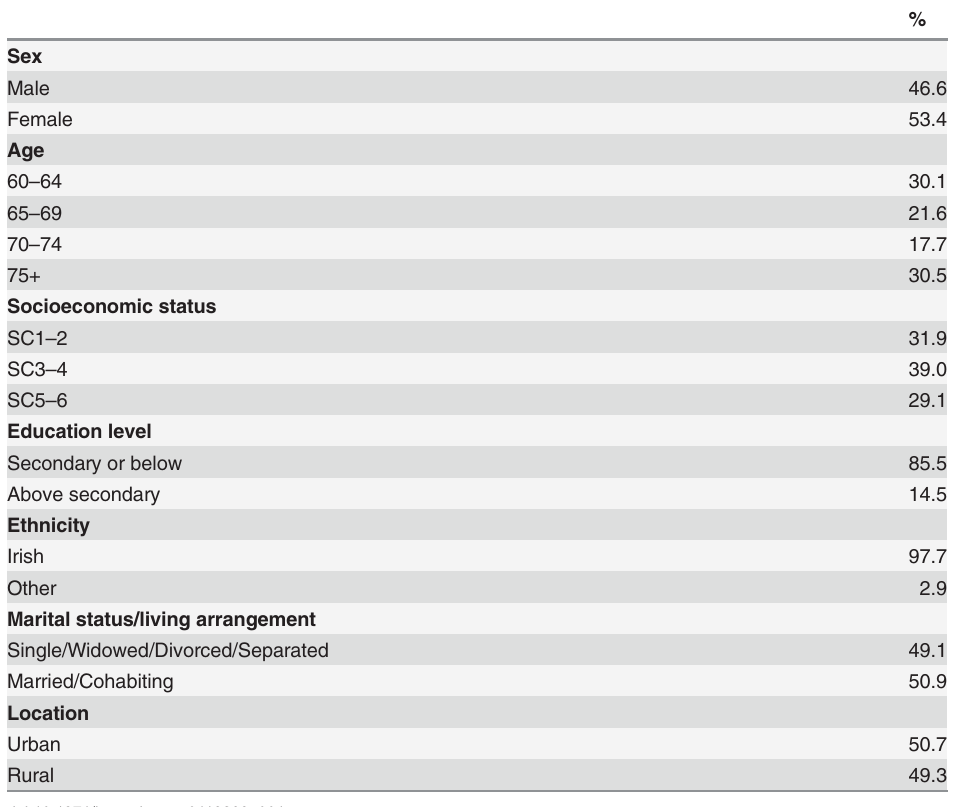
Table 1. Description of participants aged 60+ years in TILDA (n = 4892) (weighted sample